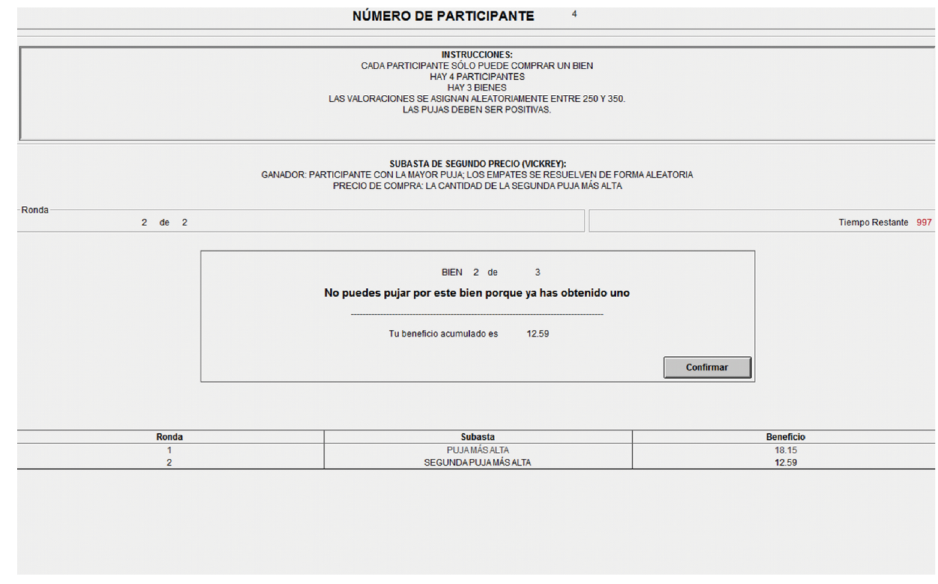
Figure A1.8. History of profits